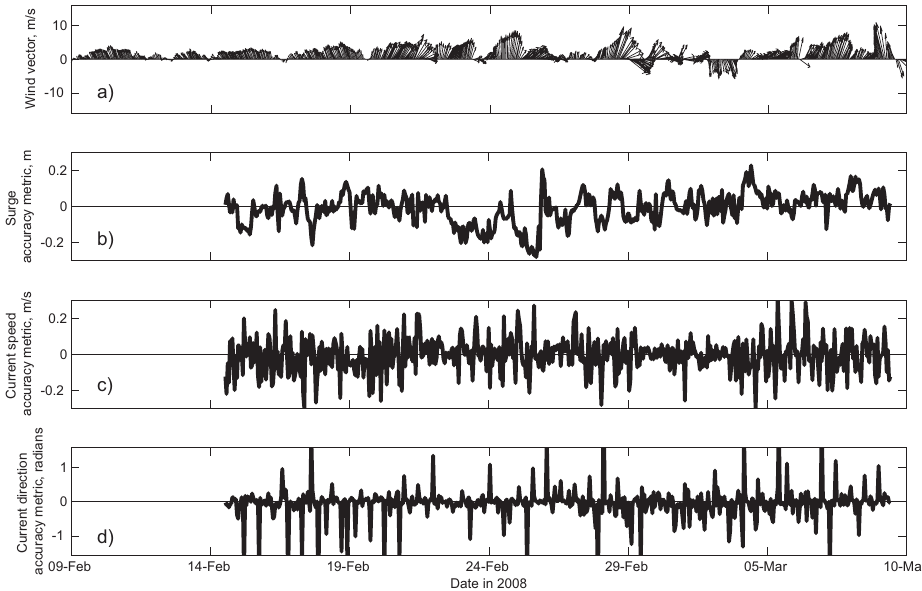
Fig. 5. Time-varying accuracy at the mooring location in the Hilbre Channel. (a) Wind vectors at this location and differential accuracy metric ( DA ) for (b) the surge, (c) the current speed and (d) the current direction. Negative values indicate the Charnock relation is performing with higher accuracy at this site than the COARE bulk wind stress formula and vice versa for positive values.